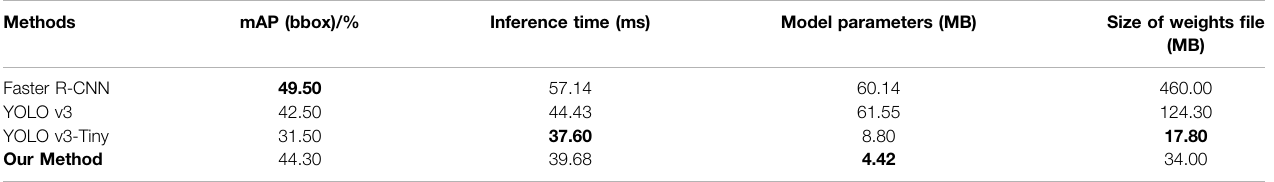
TABLE 4 | Comparison of different defect detection